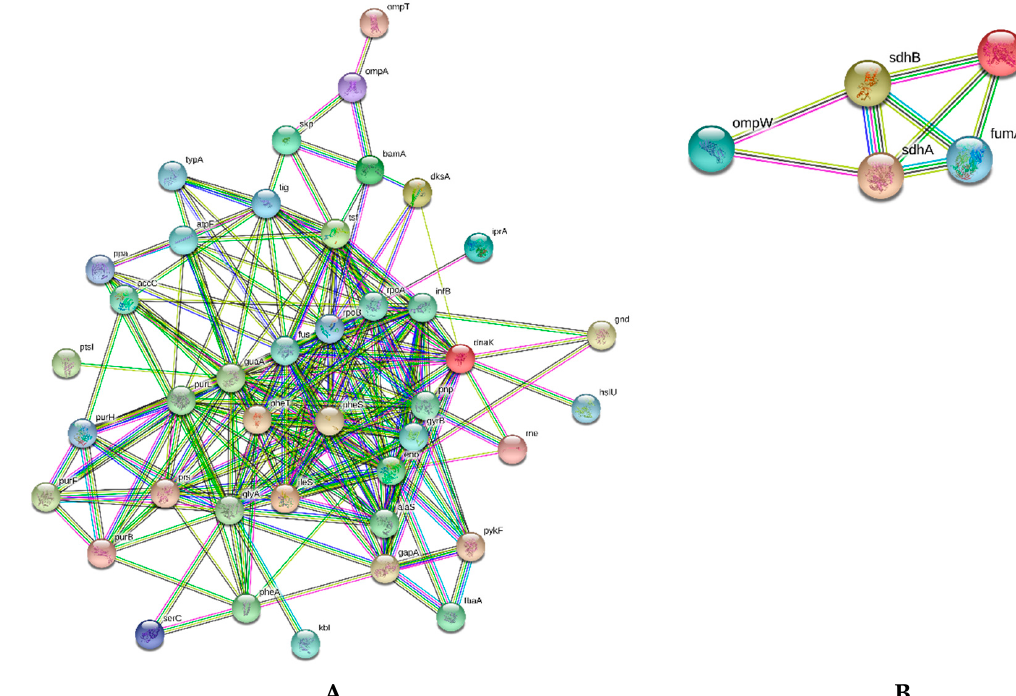
Figure 4. Graphical representation of the STRING analysis without disconnected nodes in the network. ( A ) represents the overall more abundant proteins excluding ribosomal proteins (number of edges is 1152; protein–protein interaction (PPI) enrichment p -value < 1.0 × 10 − 16 ), ( B ) represents the network of less abundant proteins (number of edges is eight; PPI enrichment p -value < 9.0 × 10 − 6 ). Protein–protein interaction identified under all experimental condition are, listed in Table 2, using 0.4 as the minimum score required for interaction, taking into account parameters concerning active interaction sources, such as bibliographic citations, data co-expression, chromosomal neighborhood, genetic fusion and